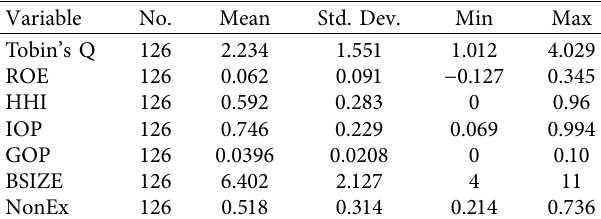
Table 1: Descriptive statistics of research